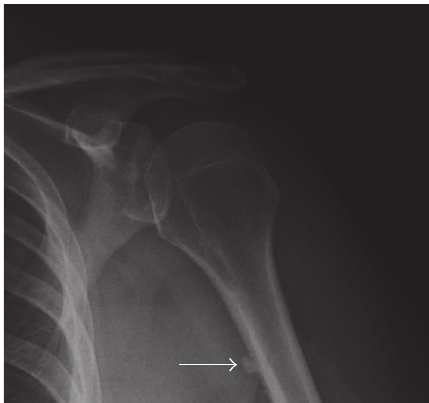
Figure 9: Calcific tendinopathy of the pectoralis major. Pectoralis major calcific tendinopathy can be seen along the anterior cortex of the proximal humerus diaphysis on lateral humerus or internal rotation AP shoulder radiographs